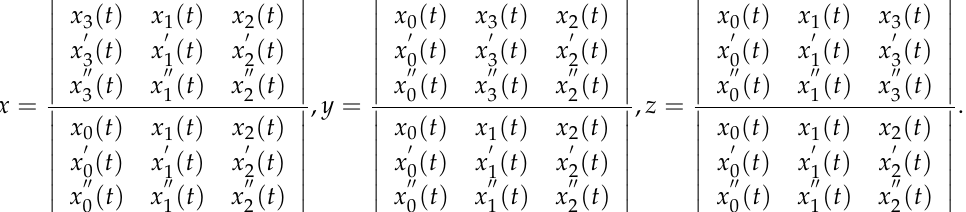
, α 2 = π , α 3 = π 4 4 4